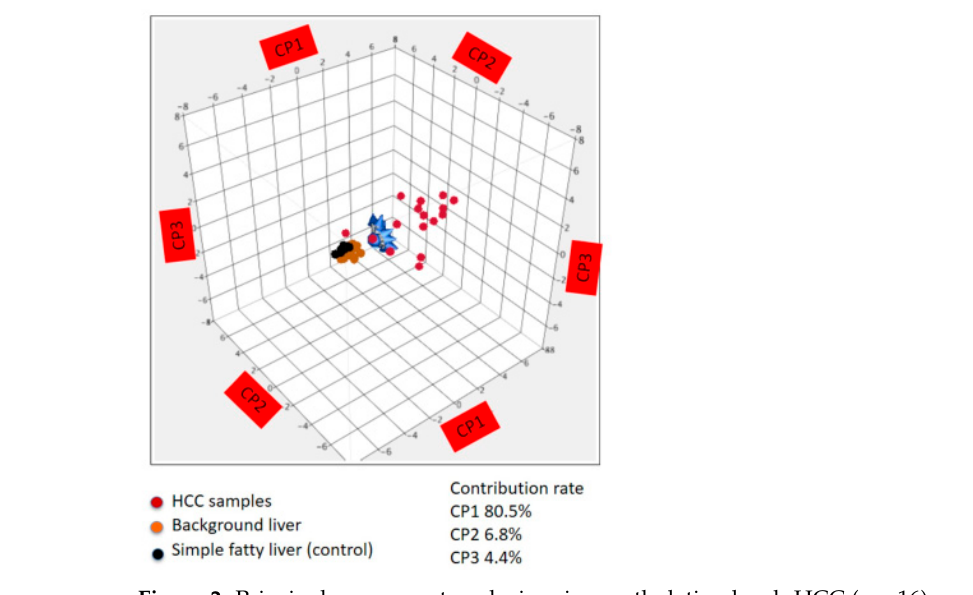
Figure 2. Principal component analysis using methylation level. HCC ( n = 16) vs. non-cancerous background liver ( n = 16) vs. simple fatty liver (control, n = 10). The methylation profile in the HCC was different from that in the non-cancerous background liver and simple fatty liver (control).